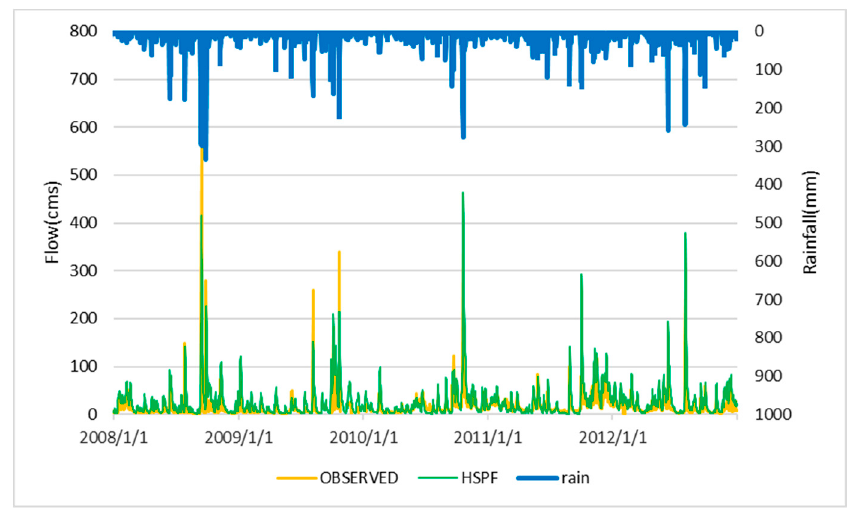
Figure 4. Flow simulation results for the HSPF model.